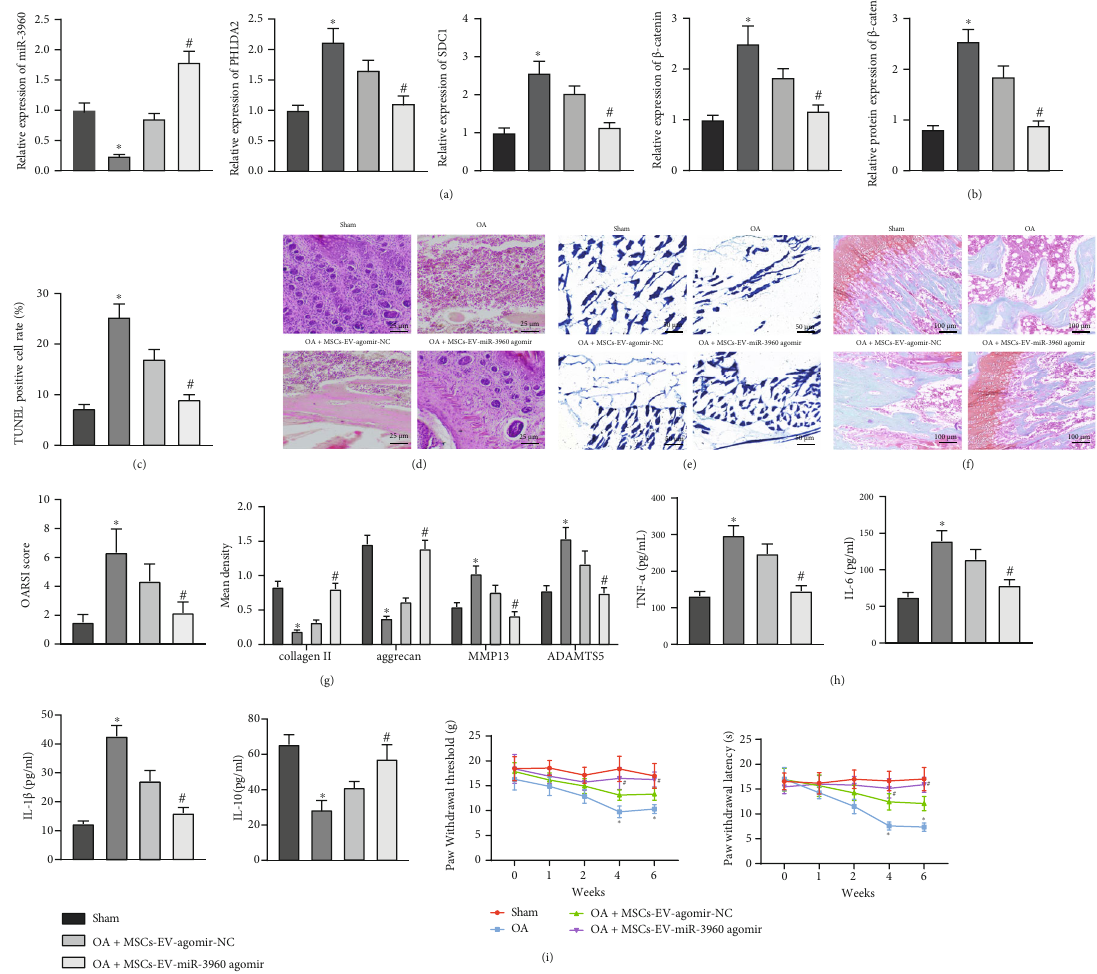
Figure 8: MSCs-EVs-encapsulated miR-3960 relieves chondrocyte in fl ammation and ECM degradation in OA mice. OA mouse models were established and injected with MSCs-EVs-miR-3960 agomir ( n = 6 ). (a) miR-3960 expression and mRNA levels of PHLDA2, SDC1, and β -catenin in chondrocytes of OA mice determined by RT-qPCR. (b) Protein levels of PHLDA2, SDC1, and β -catenin in chondrocytes of OA mice determined by immunoblotting. (c) Apoptosis of chondrocytes in OA mice detected by TUNEL assay (200 × ). (d) Articular cartilage injury of OA mice assessed by HE staining ( scale bar = 25 μ m ). (e) aggrecan content of cartilage tissues in OA mice detected by alcian blue staining ( scale bar = 50 μ m ). (f) ECM degradation of cartilage tissues in OA mice assessed by Safranin O- Fast Green staining ( scalebar = 100 μ m ) and OARSI score. (g) Protein levels of collagen II, aggrecan, MMP13, and ADAMTS5 in chondrocytes of OA mice measured by immunohistochemistry. (h) Levels of IL-6 and TNF- α in the serum of OA mice measured by ELISA. (i) PWT and PWL of mice. ∗ p < 0 : 05 vs. sham-operated mice, # p < 0 : 05 vs. OA mice injected with MSCs-EVs-agomir-NC. Data are shown as the mean ± standard deviation of three technical replicates. Data between two groups were compared by independent t -test. Data comparisons among multiple groups were analyzed by the one-way ANOVA with Tukey ’ s post hoc